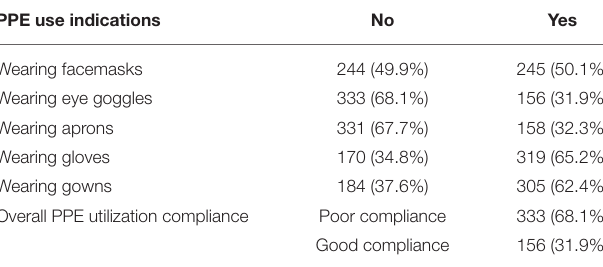
TABLE 3 | Compliance of PPE utilization measurement indications among healthcare workers in public hospitals of South Wollo Zone, Northeastern Ethiopia, 2021.